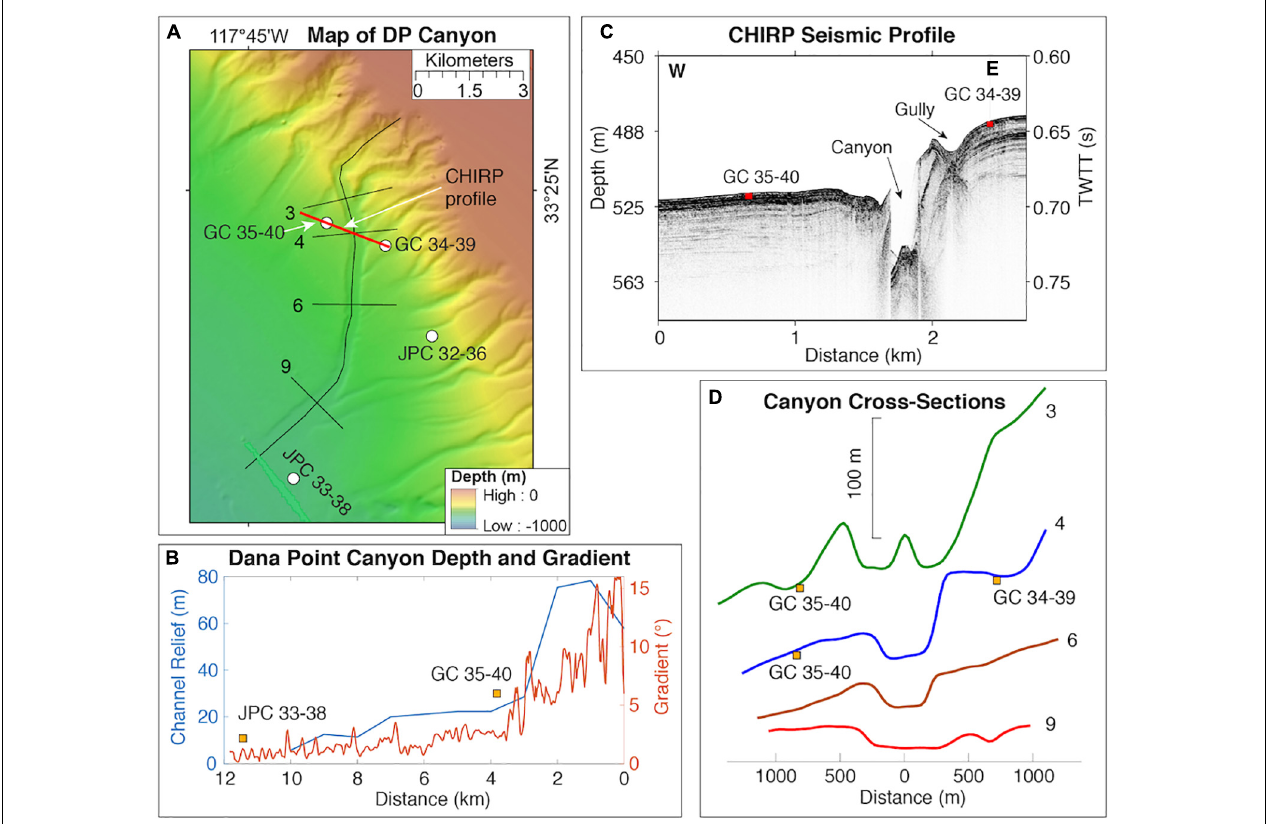
FIGURE 9 | (A) Bathymetry of the Dana Point Canyon. The location of the CHIRP profile shown in panel B is highlighted in red. Cross-sections numbers correspond to their distance (in km) from the start of the bathymetric profile and are shown in panel D . Sediment cores used in this study are also labeled. (B) Channel relief is plotted relative to channel gradient. Yellow boxes indicate the location of sediment cores along the bathymetric profile. (C) CHIRP seismic profile through GCs 35–40 and 34–39. (D) Cross sections through the DP canyon-channel are plotted. Numbers at right correspond to the distance along the bathymetric profile. Horizontal and vertical scales are shown. Sediment cores were projected onto cross-sections and are indicated by yellow